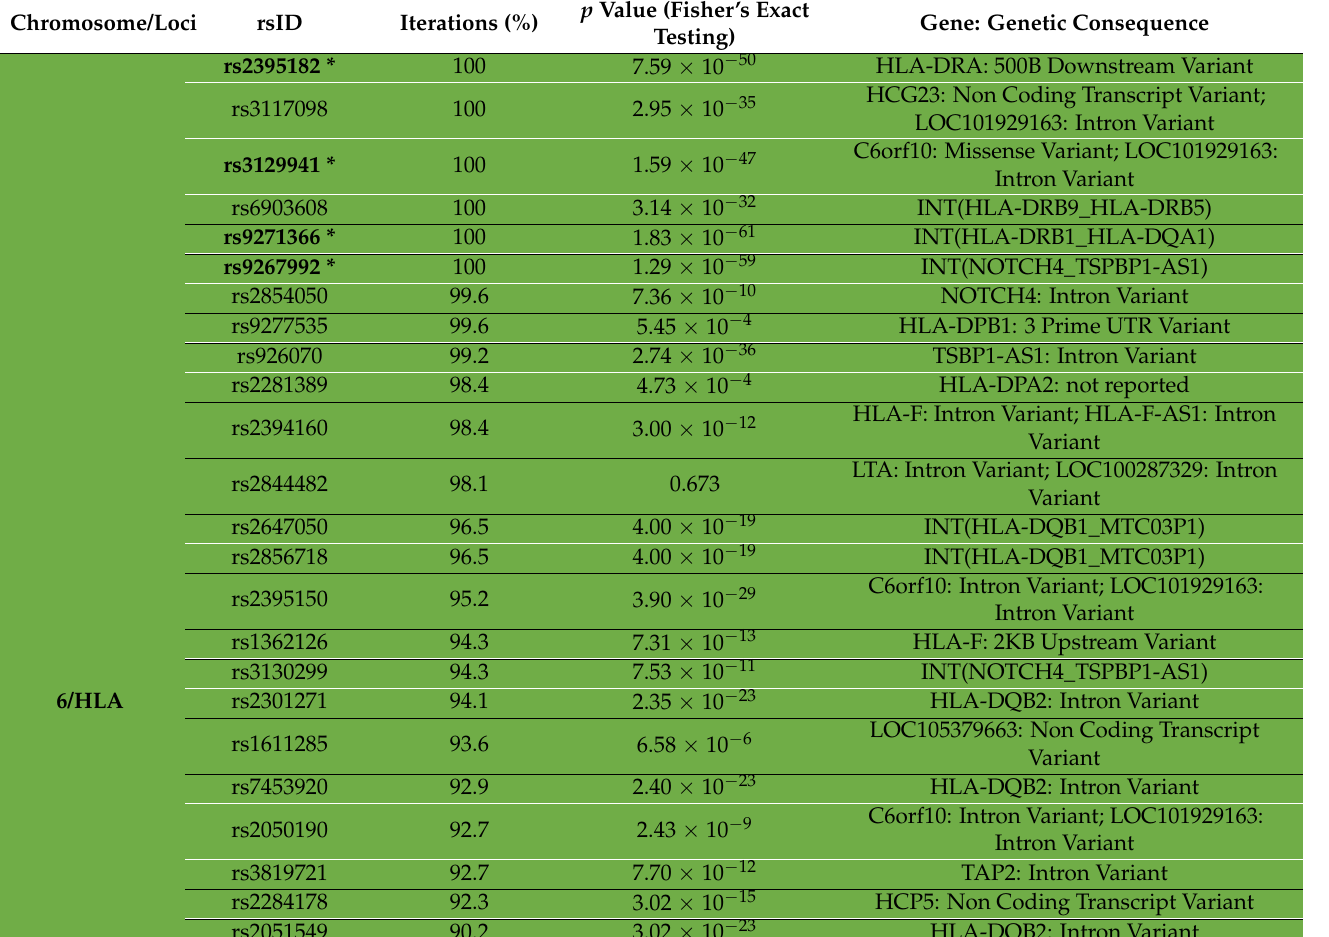
Table 3. List of SNPs above 70% iterations identified by elastic net analysis on the pre-imputed discovery cohort compared to their corresponding P value from Fisher’s exact testing. The ge- netic consequence is given for each SNP identified and intergenic SNP placements represented as INT(gene1_gene2). SNPs identified in bold * were also highlighted in Table 2 as one of the five SNPs with the lowest p value for that region. Only four out of the five SNPs for each region (from Table 2) made it above the 70% threshold; the SNPs that did not reach bootstrapping threshold were rs3132946, rs11052552 and rs1671196 for the HLA (green), NKC (orange) and LRC (blue) region, respectively. The shades of colour relates to the elastic net model range of iterations (70–79, 80–89,